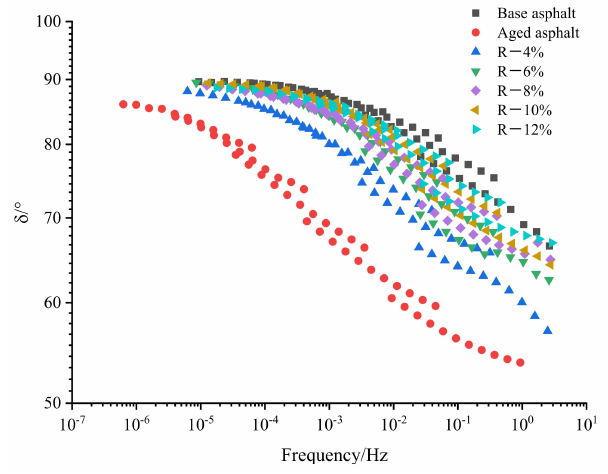
Figure 5. Master curve of phase angle of reclaimed